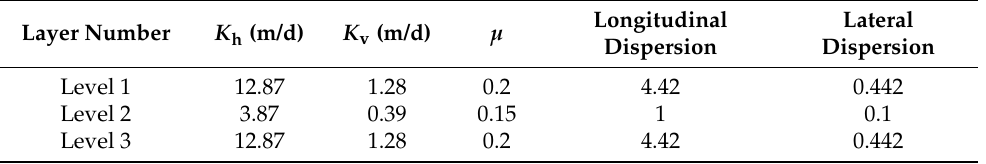
Table 4. Parameter table of the coupled groundwater solute transport